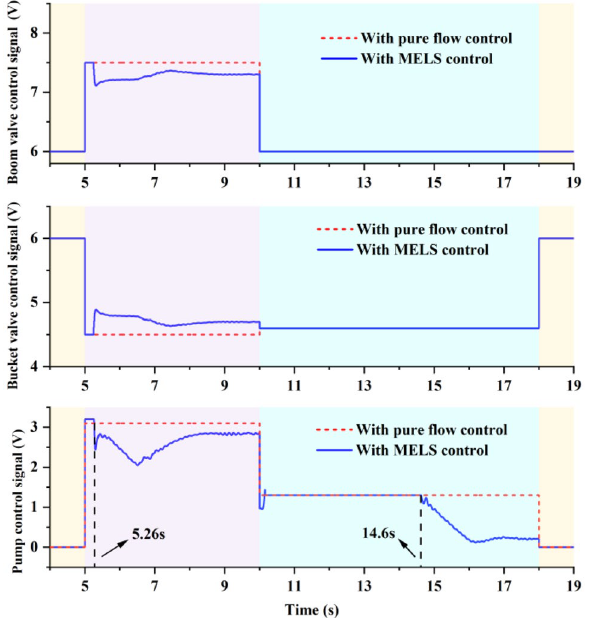
Figure 14 Control signals of the valves and pump